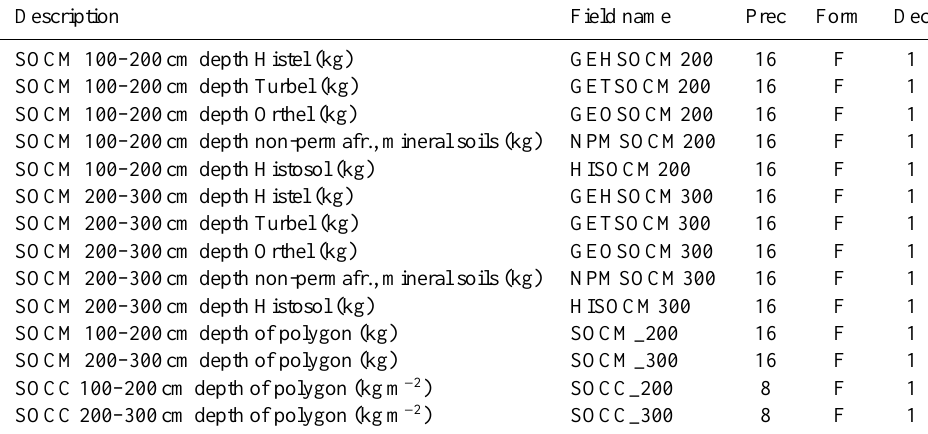
Table 2. Description of the data added to the polygon attribute tables of NCSCDv2. The table gives a description of the data, the column field name, the precision of numeric fields (Prec), the data format the variable is stored in (Form: F = float numeric field, I = integer numeric field, S = string) and the number of decimal values of float numeric fields (Dec). This table is complementary to Table 2 in Hugelius et al. (2013). This table and the polygon attribute tables of NCSCDv2 uses the abbreviations SOC content (SOCC, kgCm − 2 ) and SOC mass (SOCM, kgC) following Hugelius et al. (2013).